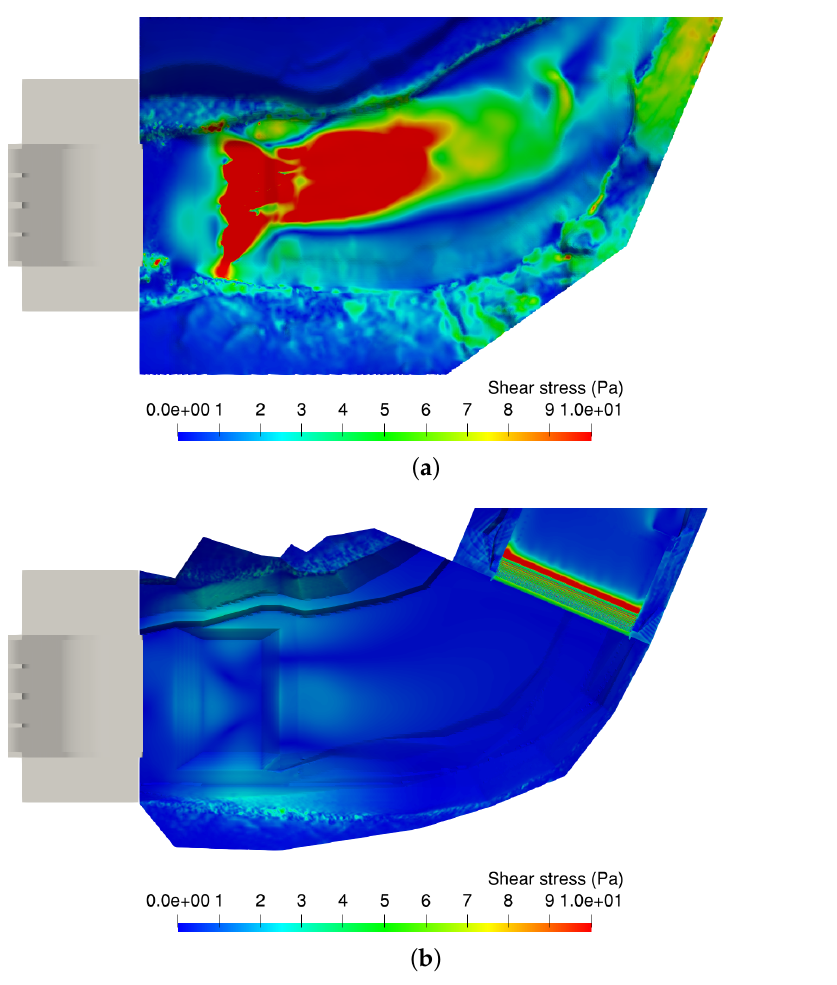
Figure 14. River bed shear stress for the simulations with ( a ) and without ( b ) the secondary